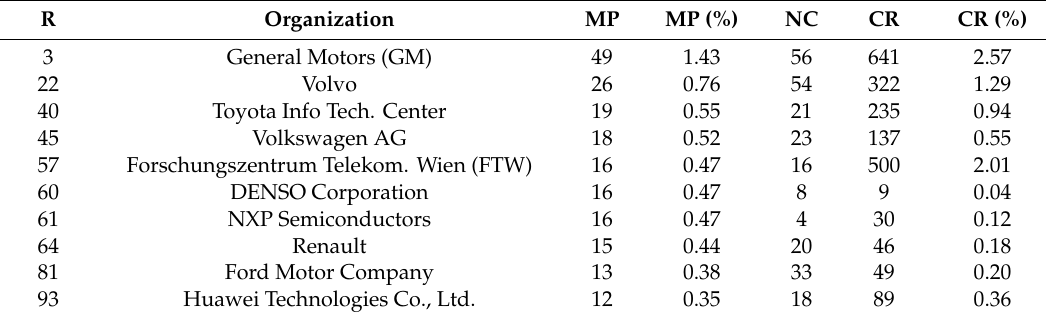
Table 3. Most productive enterprises in I2X, V2X, and P2X research from 1996 to 2018.